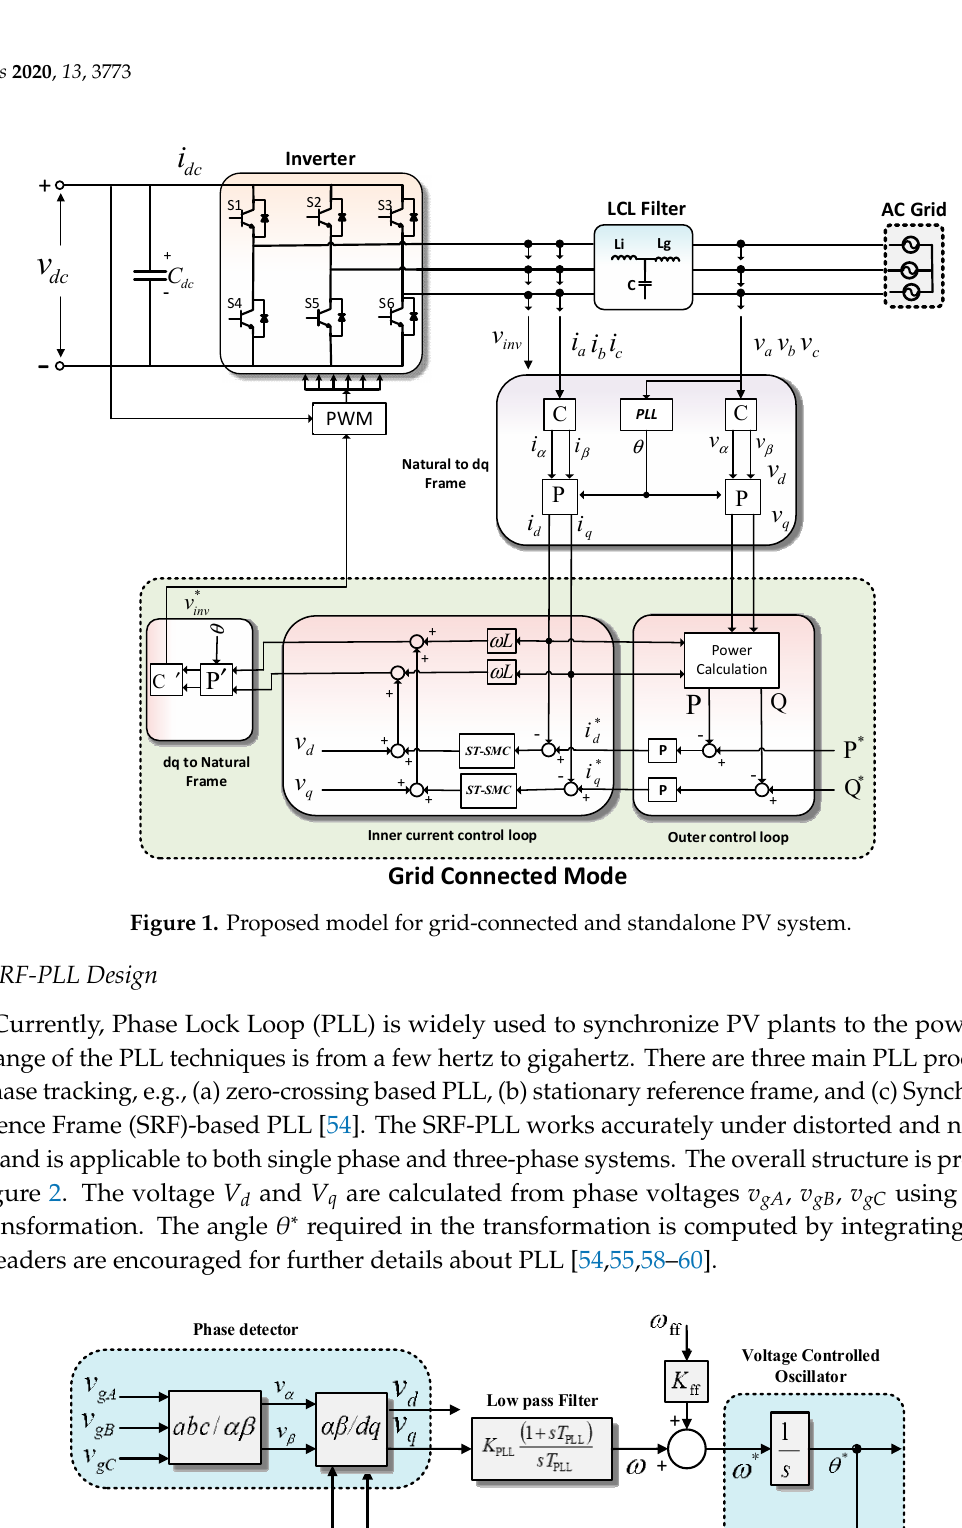
Table 1. Nominal Parameters of the System.